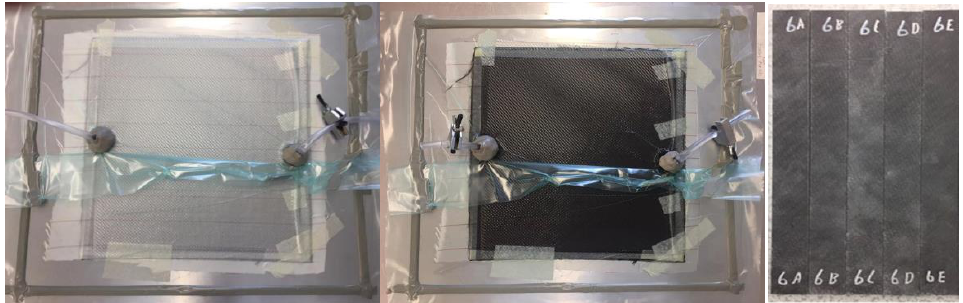
Figure 1. The setup just prior to resin infusion ( left ), an example of fully infused laminate ( centre ), and machined and labelled samples ( right ).